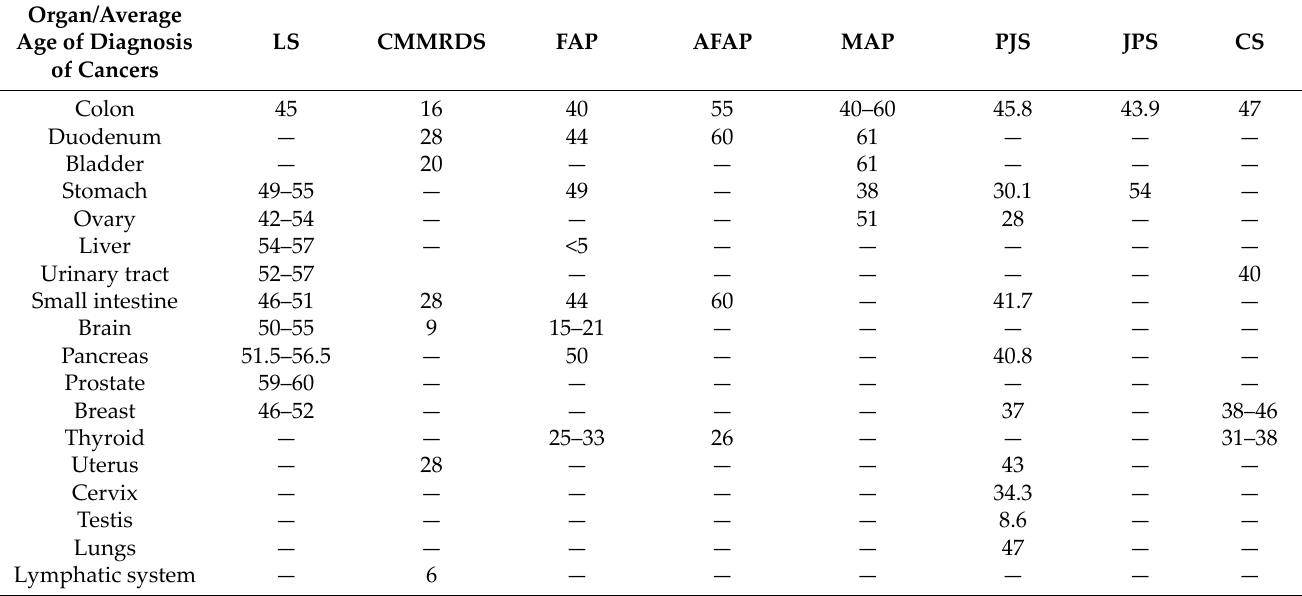
Table 4. The average age of diagnosis of cancers associated with hereditary syndromes [15,134,154,